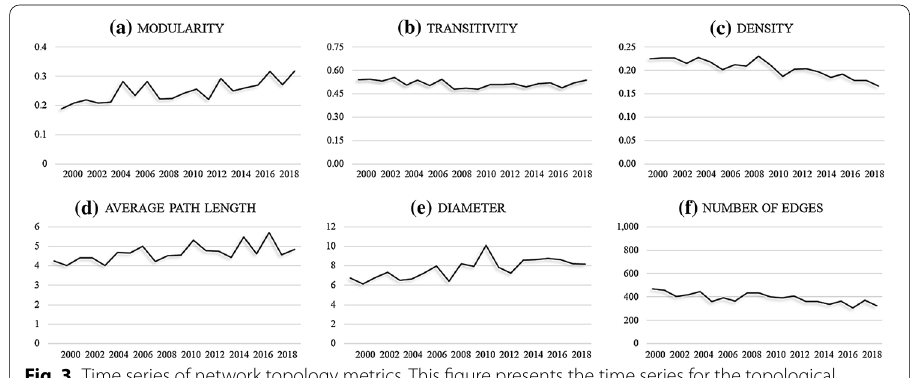
Fig. 3 Time series of network topology metrics. This figure presents the time series for the topological characteristics of the temporal network of associated topics. The decline in networkdensity and total number of edges, together with the rise in modularity, diameter, and average path length, describes and indicates anincrease in clustering of topics over time